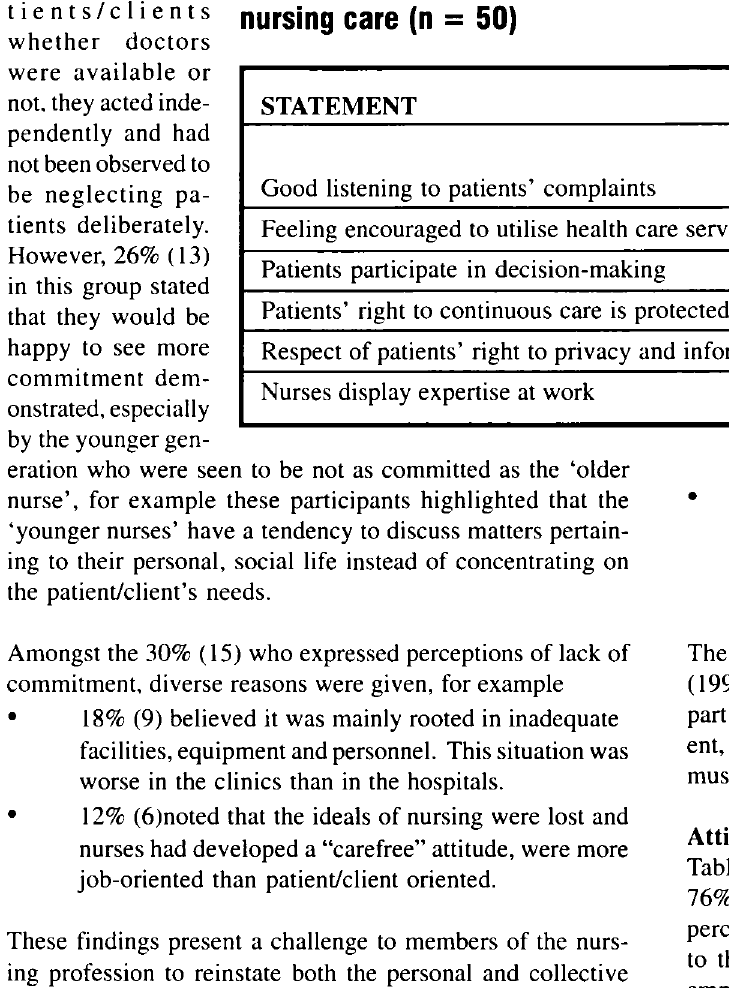
Table 3: “ Yes-no” responses on statements describing views on nurses and nursing care (n = 50)